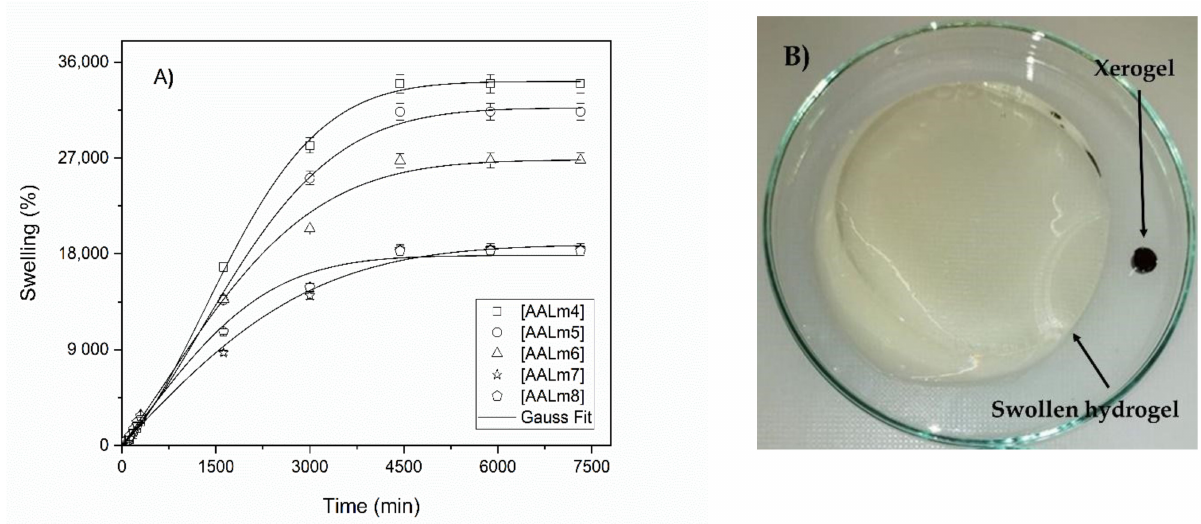
Figure 7. Swelling in water of hydrogels with AA and functionalized AKL. ( A ) Swelling behavior of hydrogels, ( B ) compar- ative capture of xerogel and swollen hydrogel.